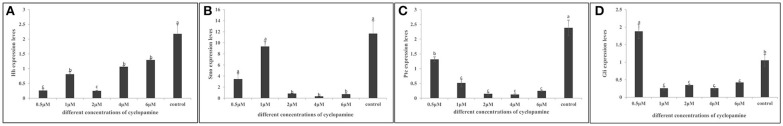
(A–D) Inhibitory effect of cyclopamine on the RNA Expression levels of key hedgehog pathway genes. The larvae in the figures was in the D-shaped stage. Different letters indicated significantly different (P < 0.05). The letters “a,” “b,” and “c” indicate the significance of the differences between two groups. Firstly, the whole mean of gene expression is ranked form large to small. The maximum average is marked the letter “a” and this average is compared with the following averages. Where the difference is not significant, the letter “a” is marked; otherwise, the letter “b” is marked. Secondly, the maximum average marked “b” is used as the standard deduction and compared with the following unmarked averages. Where the difference is not significant, the letter “b” is marked; otherwise, the letter “c” is marked. ad, adductor muscle; vr, velum retractor muscle; lr, larval retractor.